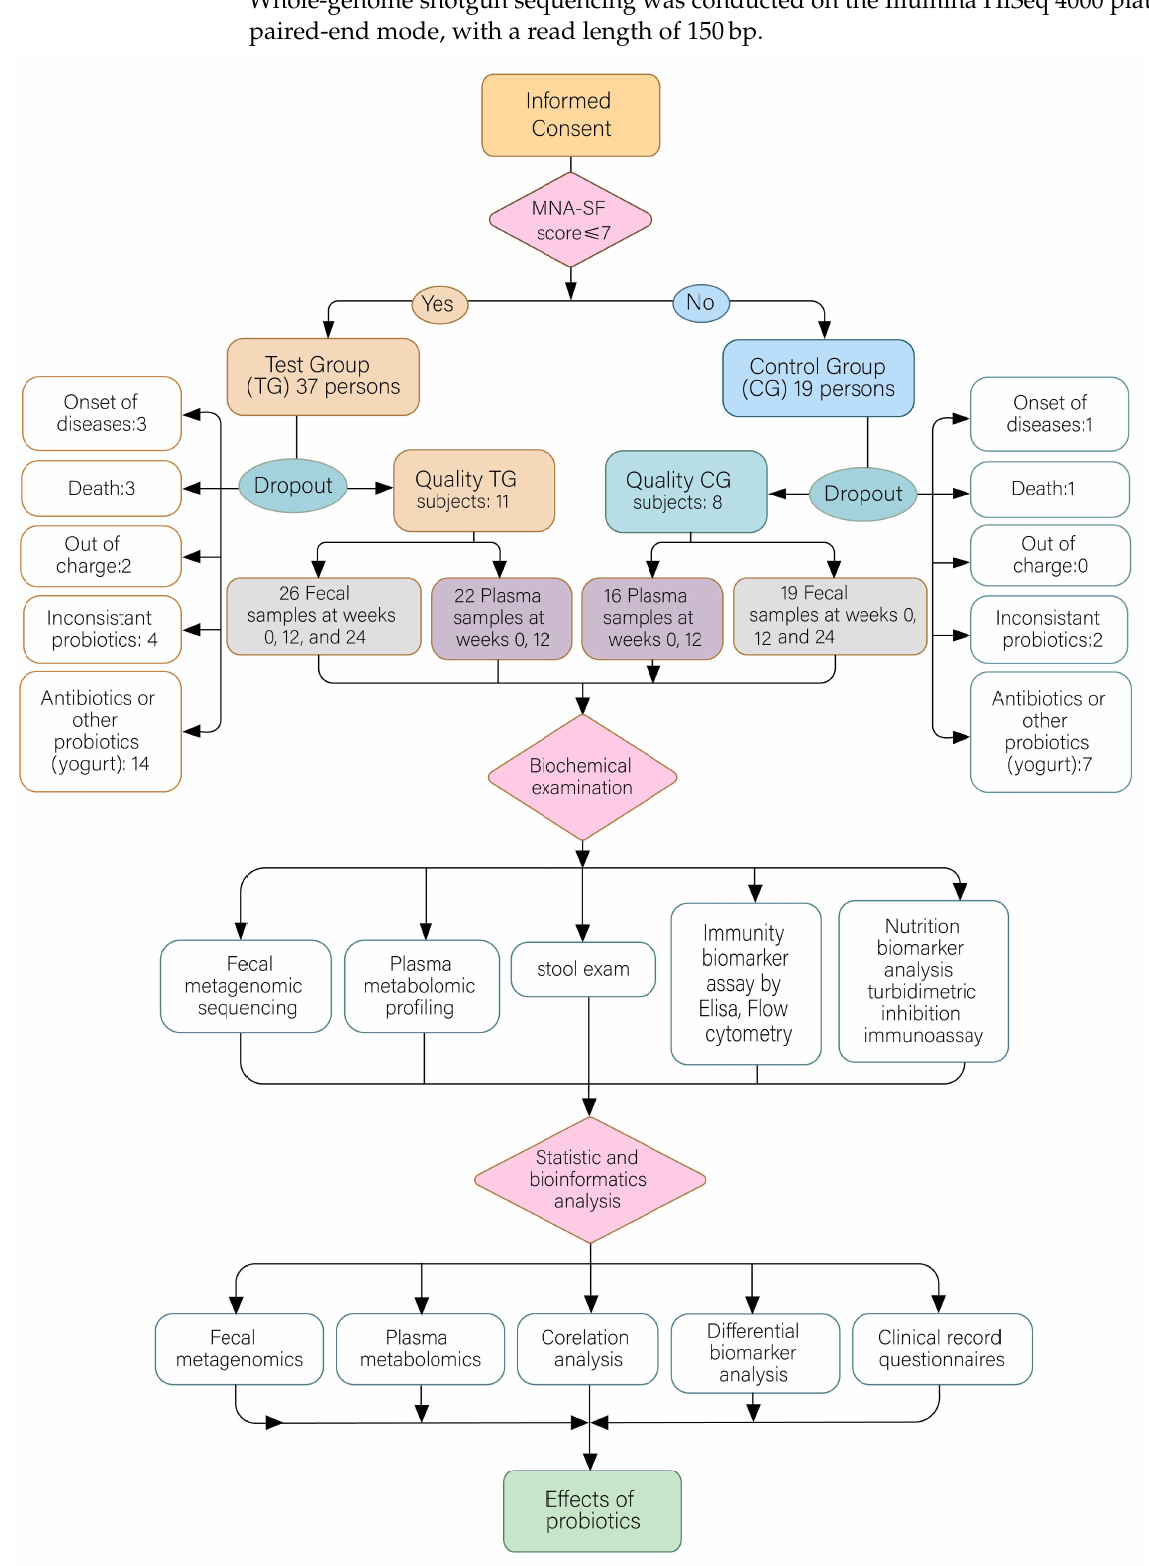
Figure 1. Flowchart of the probiotic intervention study with enrolled elderly